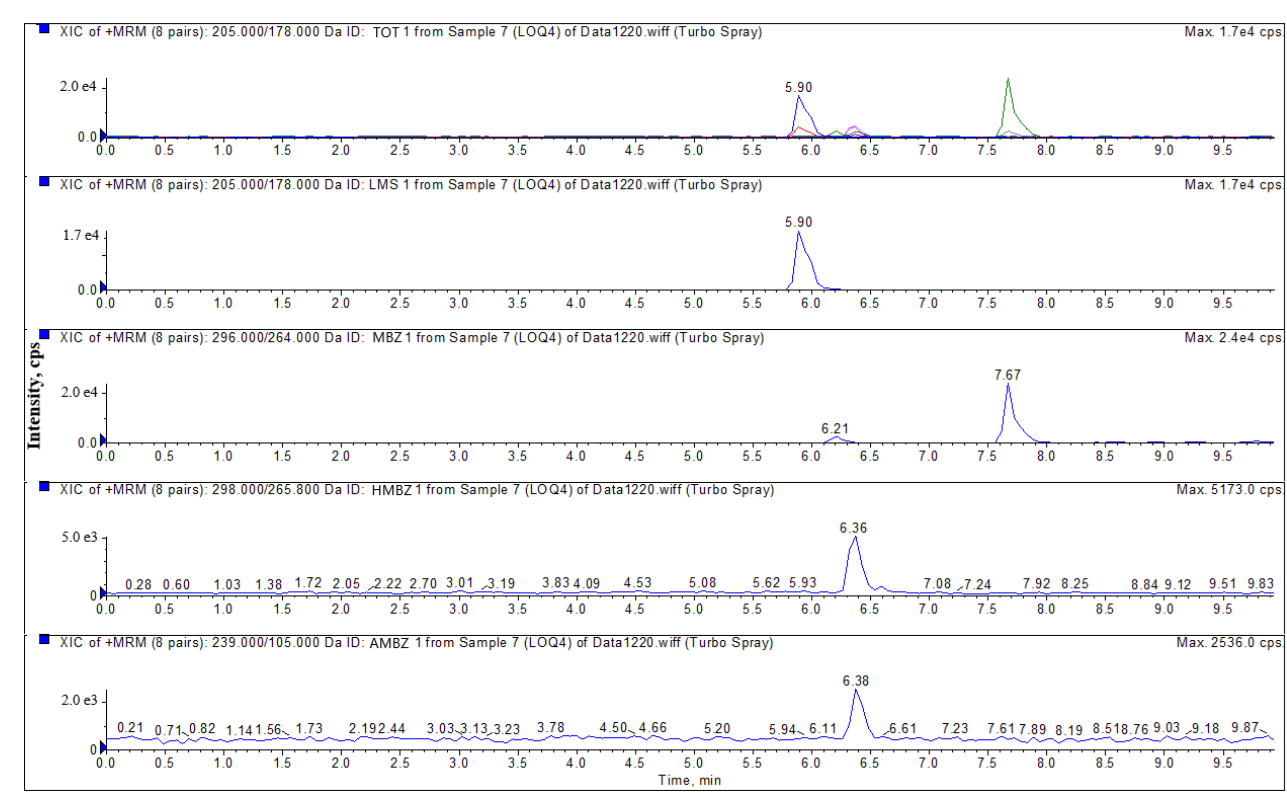
Figure 2. Total ion chromatograms and extracted ion chromatograms of a blank duck muscle matrix spiked with the LOQ of the standard added. The colored peaks on the total ion chromatogram correspond to those of the four analytes: LMS, blue; MBZ, green; HMBZ, rose red; AMBZ, light blue.